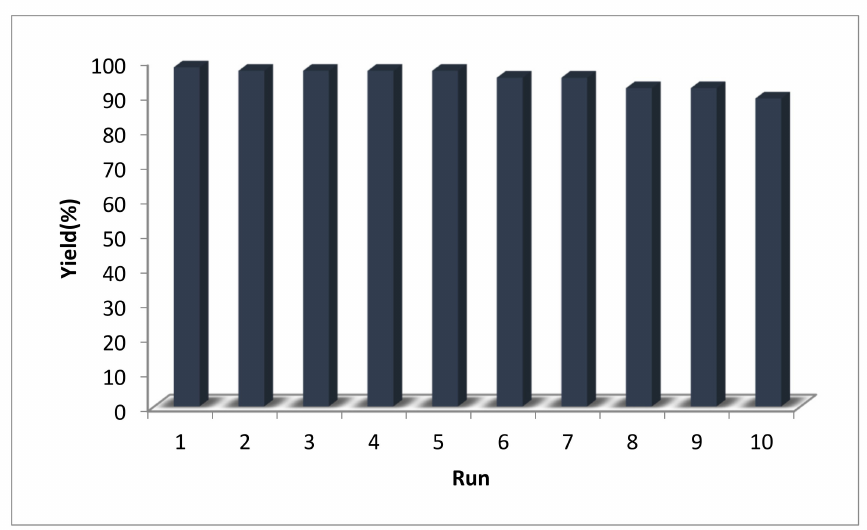
Figure 1. Recycling activities obtained for the nanocatalyst after 10 runs. Reaction conditions: benzaldehyde (5 mmol), MeOH (3 mL), Pd-Cyt@SBA-15 (14 mg, 0.005 mmol), 50 ◦ C, O 2 (filled balloon), and 5 h.